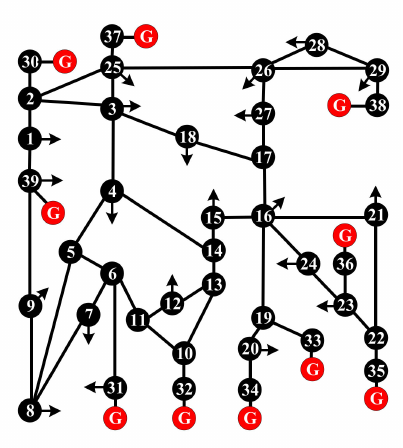
Figure 6. IEEE-39 bus power system.